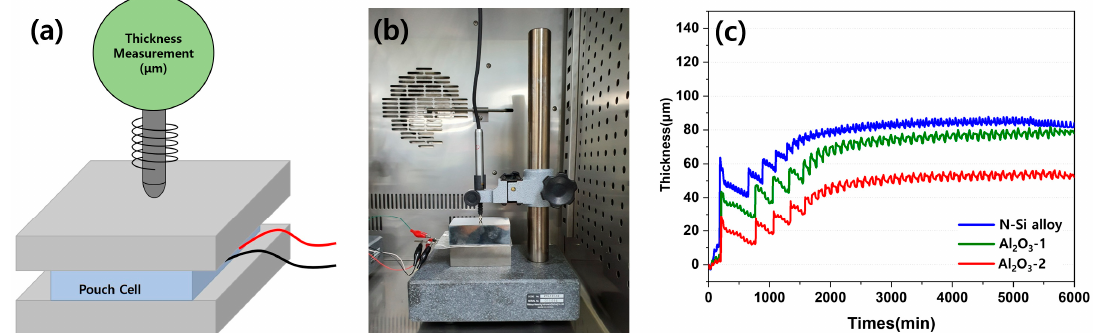
Figure 14. ( a ) Schematic diagram of the setup for detecting SLPC volume expansion and